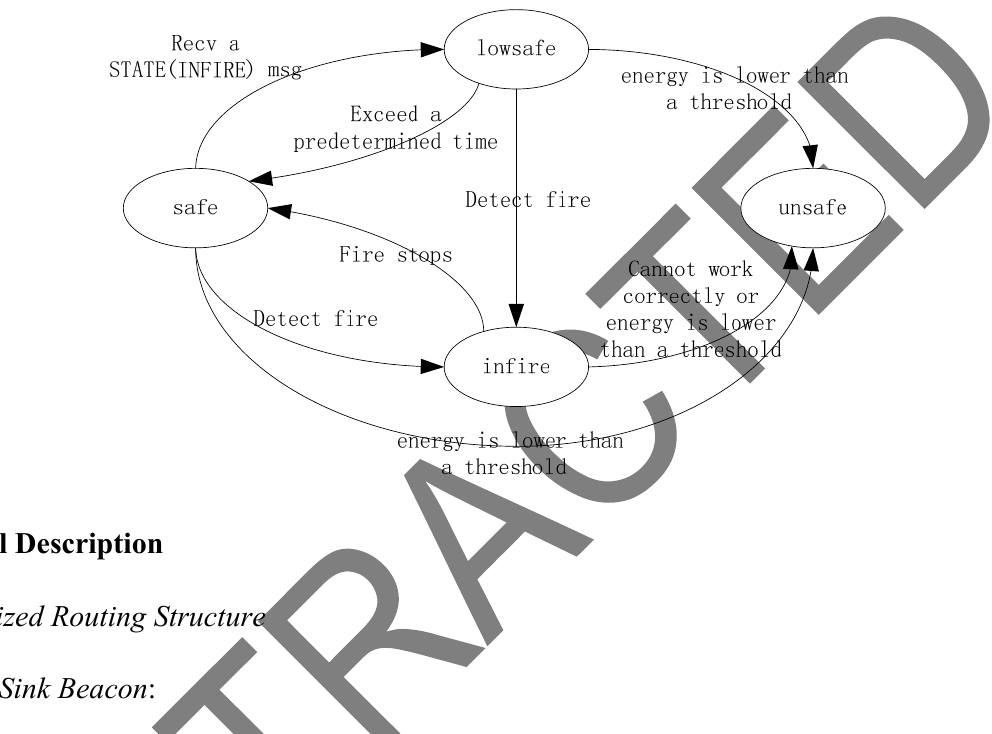
Figure 1. State transition diagram for each